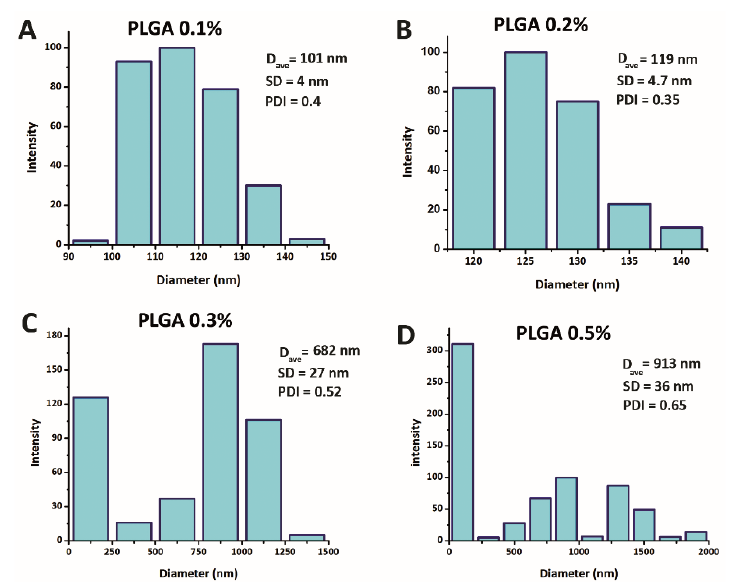
Figure 4. NPs size and their size distribution curves based on dynamic light scattering (DLS) at different PLGA concentrations: ( A ) 0.1 (% w/v), ( B ) 0.2 (% w/v), ( C ) 0.3 (% w/v) and ( D ) 0.5 (% w/v). (The p-value for all data was less than 0.05).